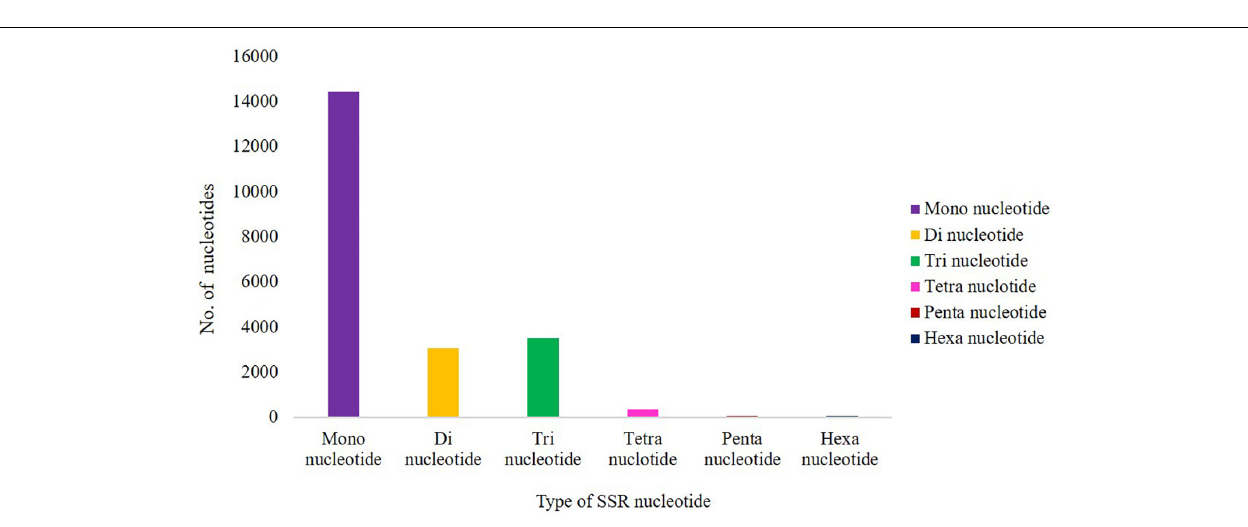
FIGURE 5 | Distribution of different classes of SSRs in cluster bean cultivar